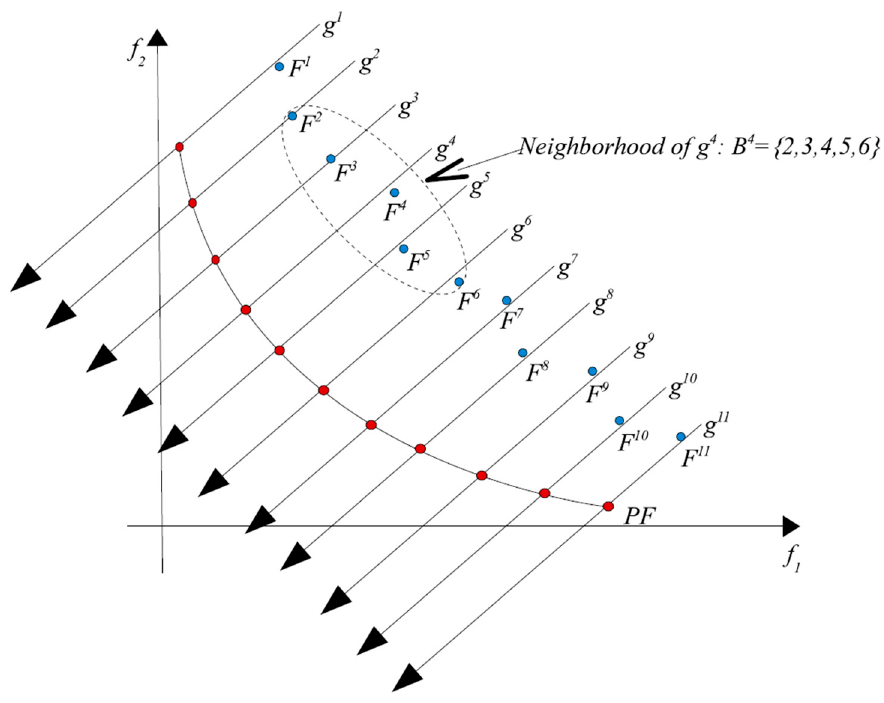
Figure 2. Illustration of the basic idea of MOEA/D.